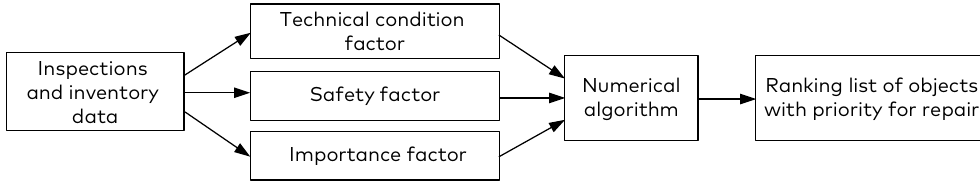
Figure 1. The general scheme for determining the ranking